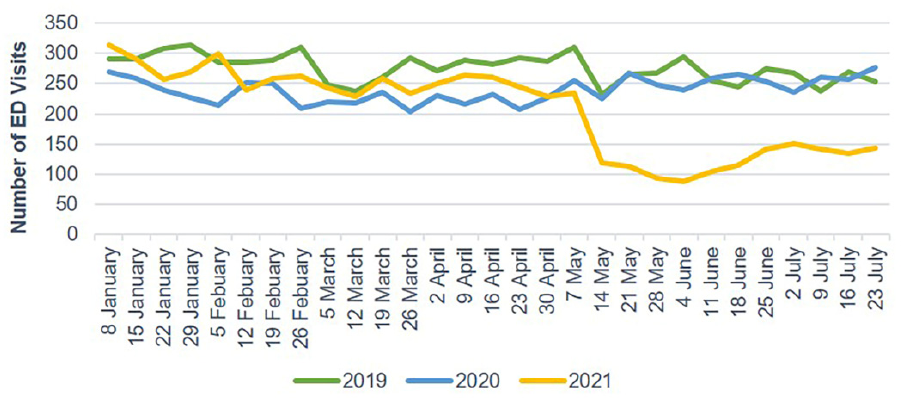
Figure 3. Weekly TBI-related ED visits from January to July 2019, 2020, and 2021. ED, emergency department; TBI, traumatic brain injury.